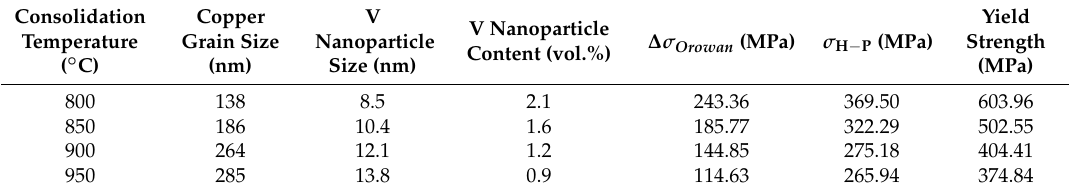
Table 2. Results of calculative ∆ σ Orowan and σ H − P